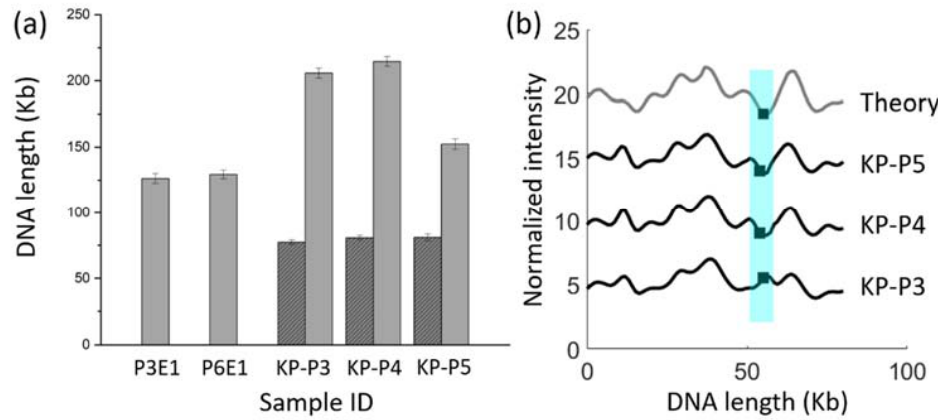
Figure 3. ( a ) Lengths of plasmids found in the five different isolates. Dark gray-shaded bars represent plasmids where the bla CTX-M-15 gene was identified. ( b ) Barcodes of ~80 kb plasmids with the bla CTX-M-15 gene in the KP-P3, KP-P4 and KP-P5 isolates (black), compared to the theoretical barcode generated from long-read sequencing (gray). Black squares within the highlighted region represent the position of the bla CTX-M-15 gene.